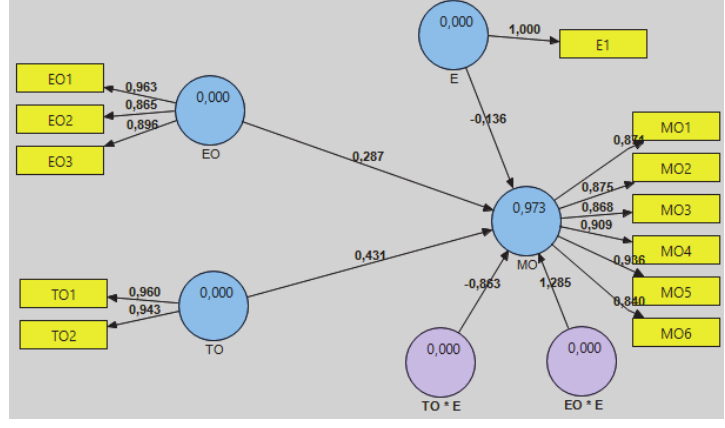
Fig. 3. Result of factor loading calculation